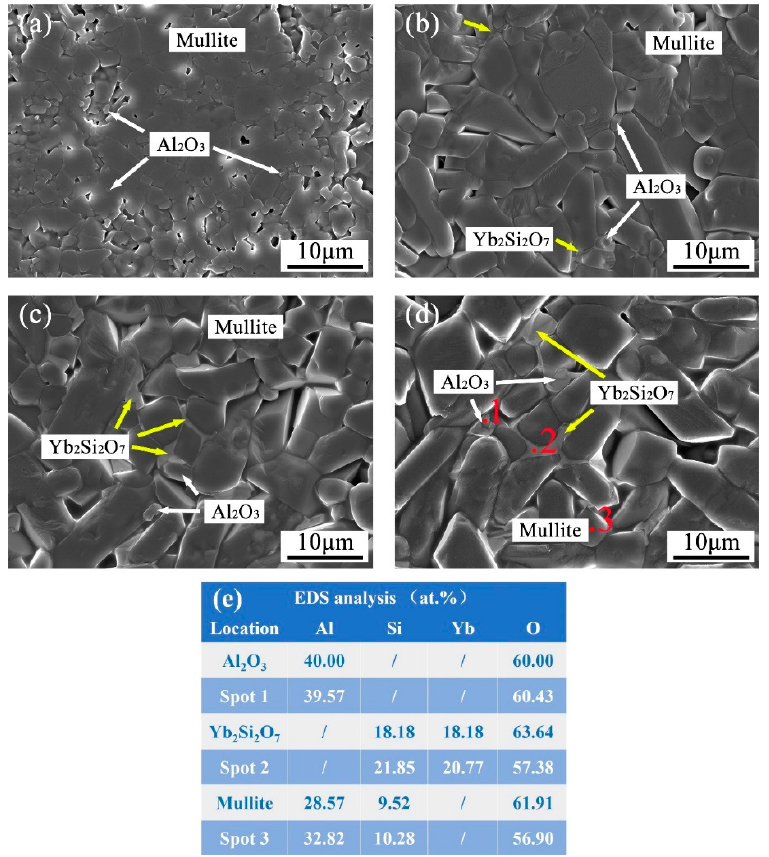
Figure 3. SEM micrographs of hot corrosion surface of ( a ) mullite, ( b ) 5YbAM, ( c ) 10YbAM, ( d ) 15YbAM samples and ( e ) energy dispersive spectrometer (EDS) analysis of three grains in ( d